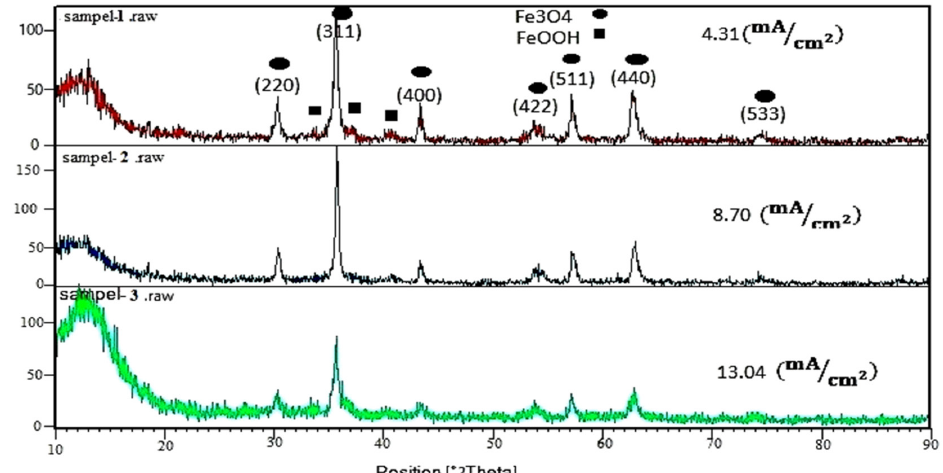
Fig.1. XRD patterns of the nanoparticles prepared by electrochemical method in presence of NaOH and by changing the current density. The distance between electrodes wes adjusted to be 4 cm.